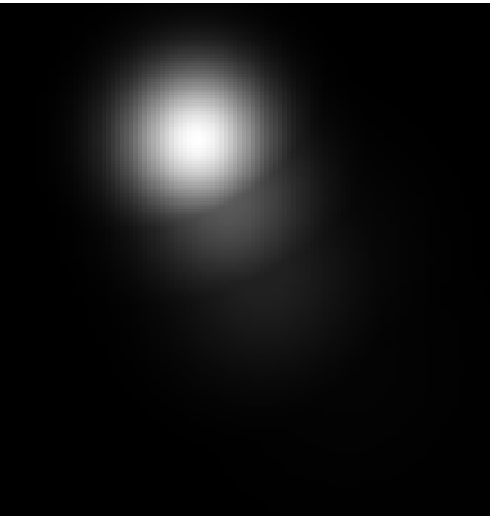
Figure 4. An example of trajectory distribution map. The brighter the position, the greater the probability of object